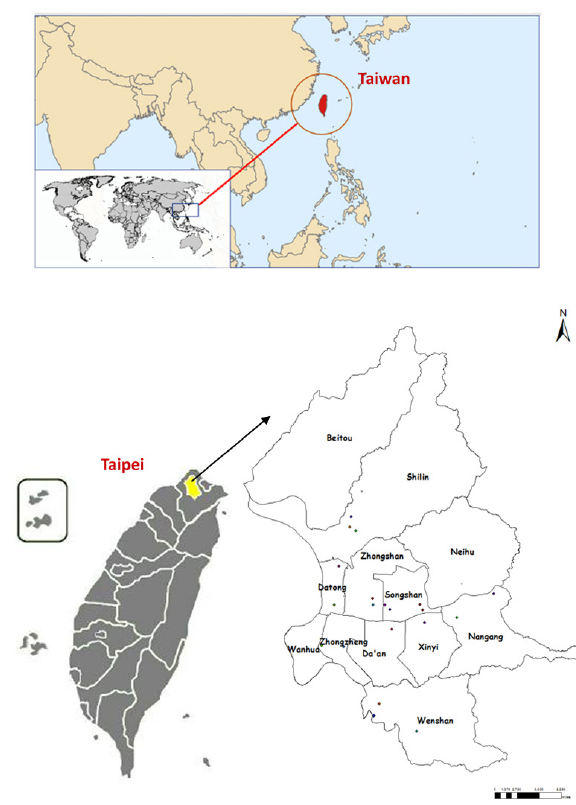
Figure 1. Taipei city urban renewal case map (The dots represent urban renewal